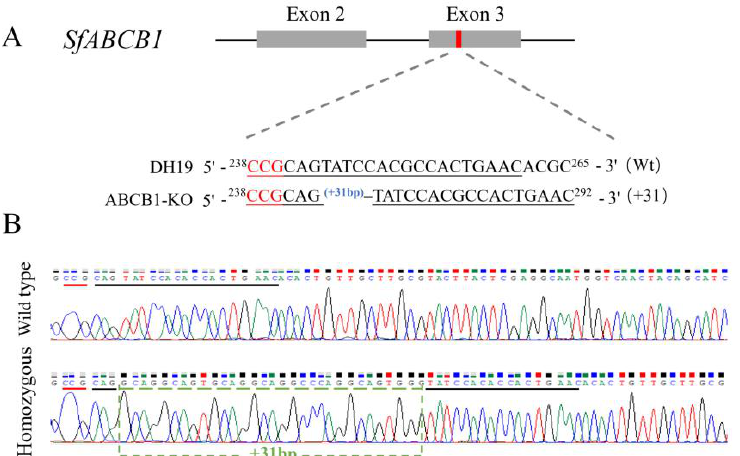
Figure 1. Schematic diagram of the knockout of SfABCB1 . ( A ) Schematic diagram of the sgRNA- targeting sites. The black line indicates the genome locus of Spodoptera frugiperda ABCB1 ( SfABCB1 ) and the two grey boxes represent the two exons of SfABCB1 . The sgRNA-targeting site was located on the sense strand of exon-3. The sgRNA-targeting sequence is in black, and the protospacer adjacent motif (PAM) sequence is in red. ( B ) Representative chromatograms of polymerase chain reaction (PCR) product sequencing of G0 moths, and the indel mutation is presented in the green box.